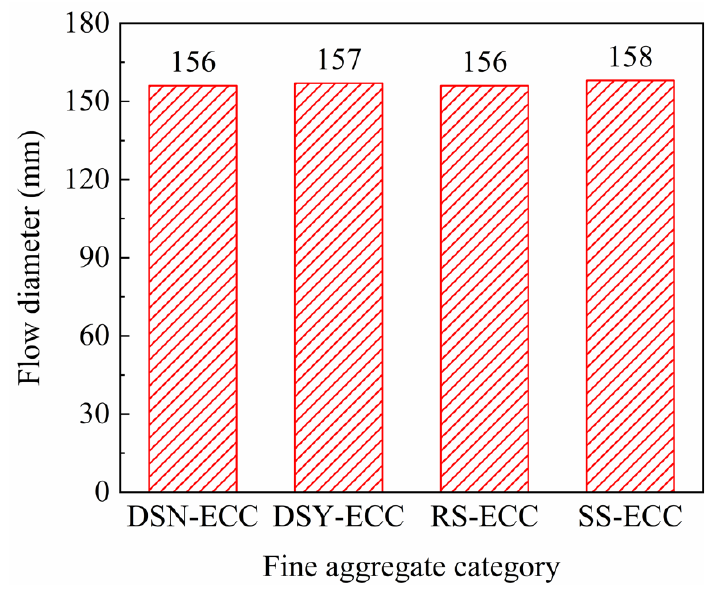
Figure 3. Flow diameter of different fine aggregate fresh